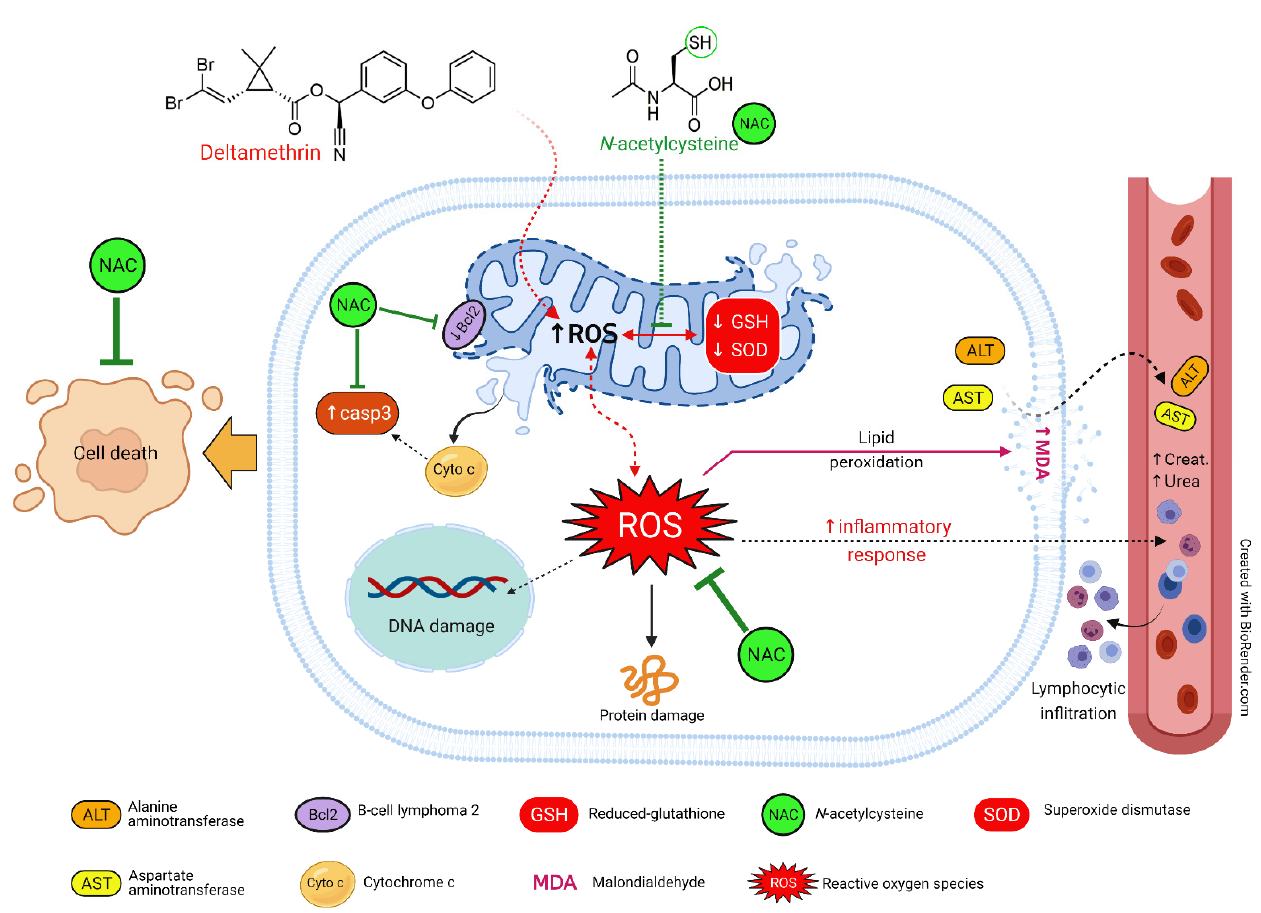
Figure 7. The proposed mechanistic insights associated with the protective activity of NAC against DLM-induced toxicity.